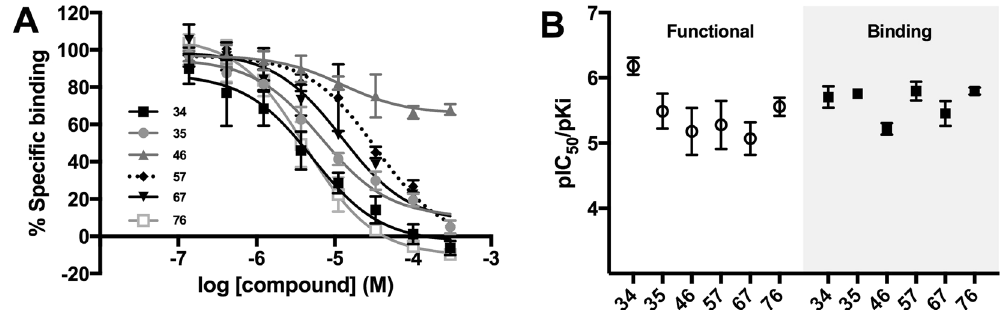
Figure 4. ( A ) Radioligand competition binding assay validates hits at the H 3 receptor. Representative curves of the competitive binding of [ 3 H] N - α -methylhistamine (0.3 nM) in the presence of various concentrations of compounds. Data points are shown as the mean ± S.D. of triplicate measurements. ( B ) The obtained affinities correlate with the potencies obtained in the functional assay. The potencies of the six most potent compounds obtained from the IP-One assay ( Functional ) shown as pIC 50 compared with their affinities as determined in the radioligand competition binding assay ( Binding ). All data points are shown as the mean ± S.E.M, n =